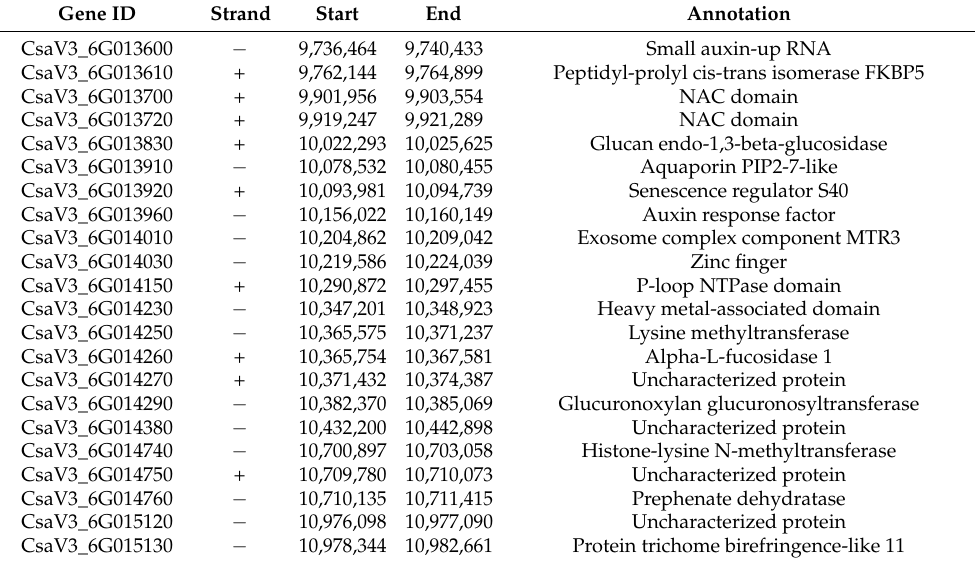
Table 2. Annotation of DEGs enriched at qLTT6.2